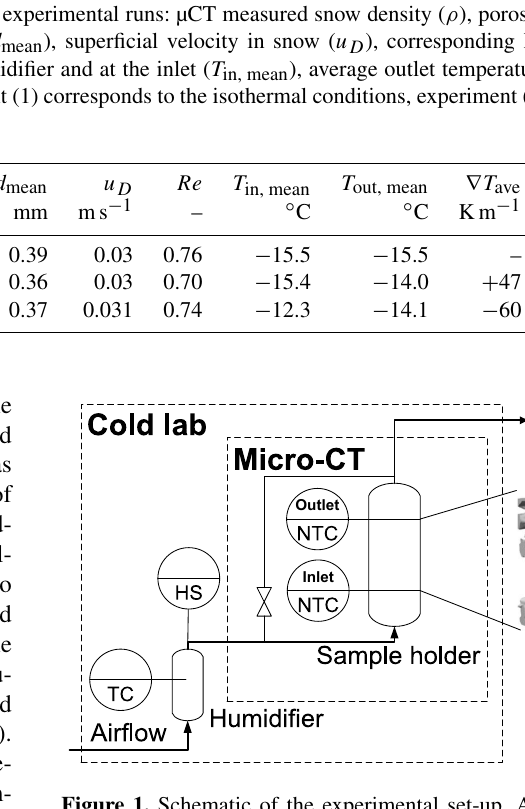
Figure 1. Schematic of the experimental set-up. A thermocouple (TC) and a humidity sensor (HS) inside the humidifier measured the mean temperature and humidity of the airflow. Two thermistors (NTC) close to the snow surface measured the inlet and outlet tem- perature of the airflow (Ebner et al., 2014). The Picarro analyser measured the isotopic composition δ 18 O of the outlet flow. Inset: 3-D structure of 110 × 42 × 110 voxels (2 × 0 . 75 × 2mm 3 ) obtained by the